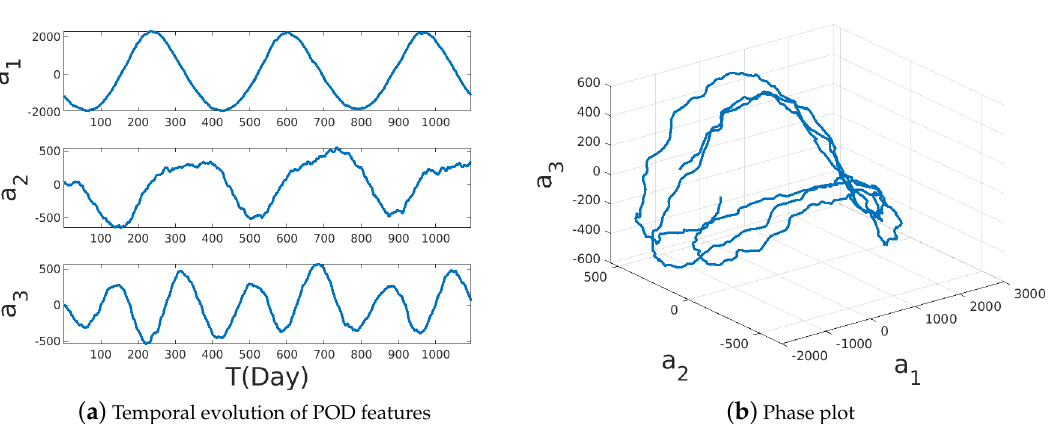
Figure 6. The temporal evolution of the first three normalized POD coefficients for the sea surface temperature (SST)